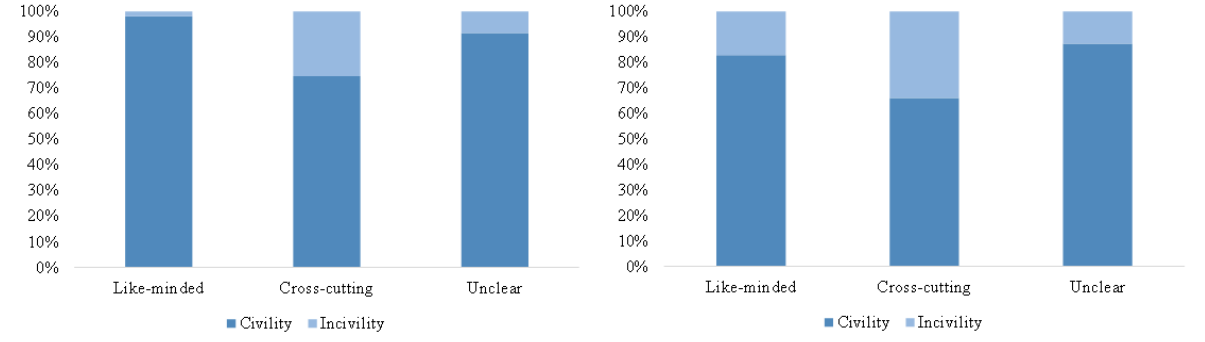
Figure 10. The proportion of civility and incivility in different kinds of interactions in retweets (left) and comments (right).